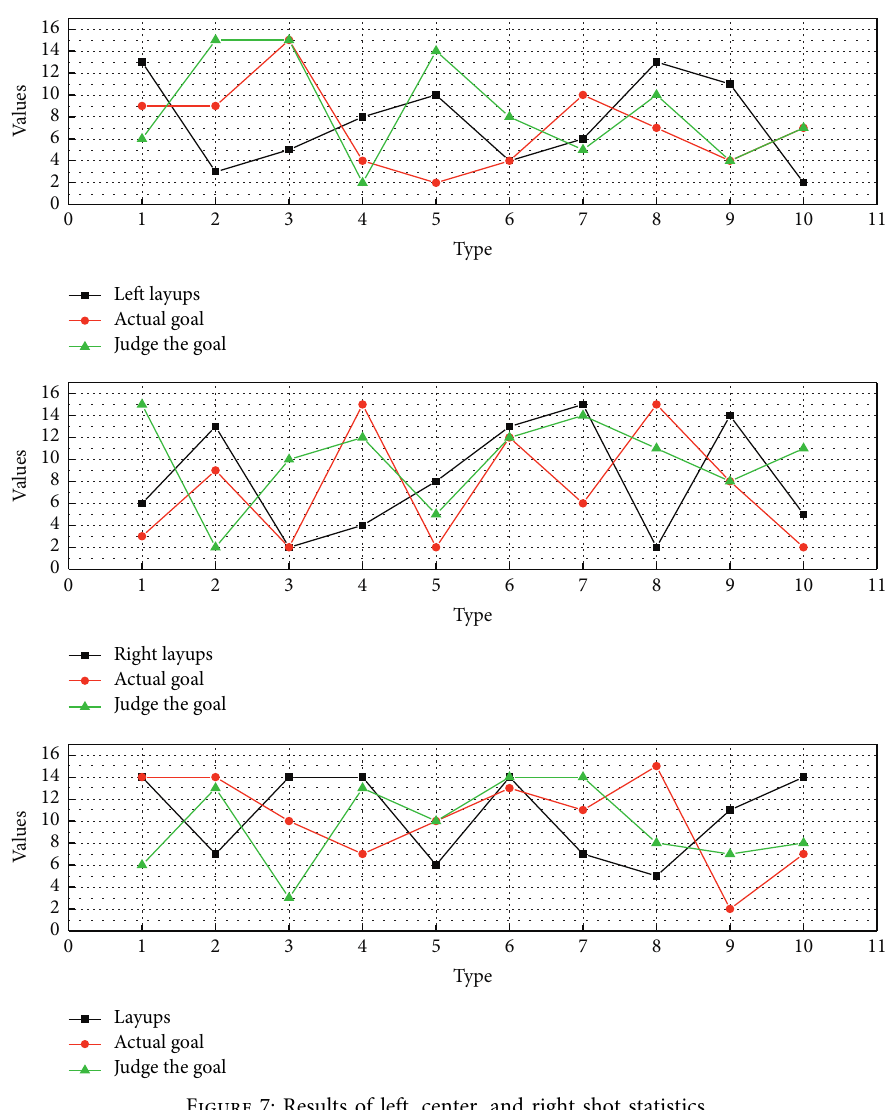
Figure 7: Results of left, center, and right shot statistics.